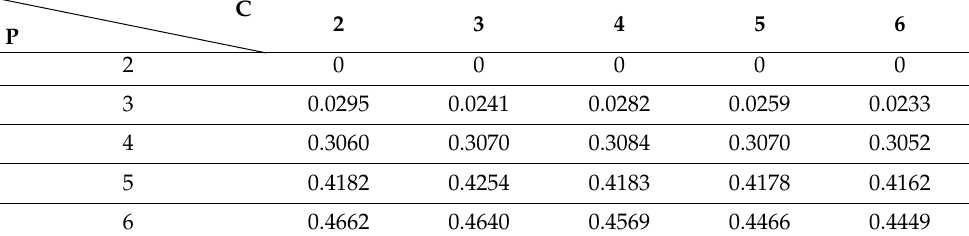
Table 2. Prediction performance CGK-based fuzzy granular model that generated contexts flexibly. P